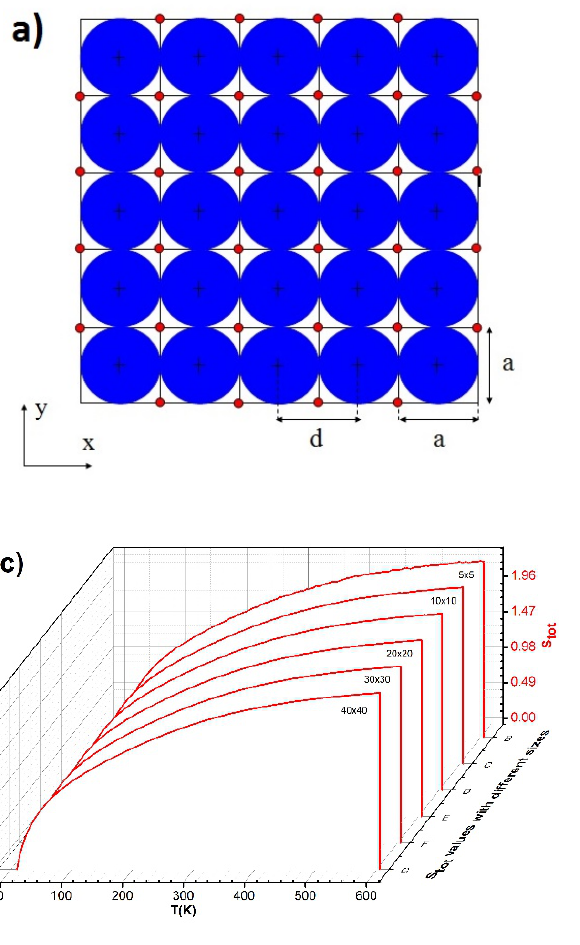
Figure 3. Shape ( a ), synthetic magnetization ( b ), synthetic entropy ( c ), Néel phase transition temperature ( d ) of Fe 2 O 3 nano synthetic thin film in magnetic field B = 0.1 T with a rotation angle of α = 90° for different matrices.